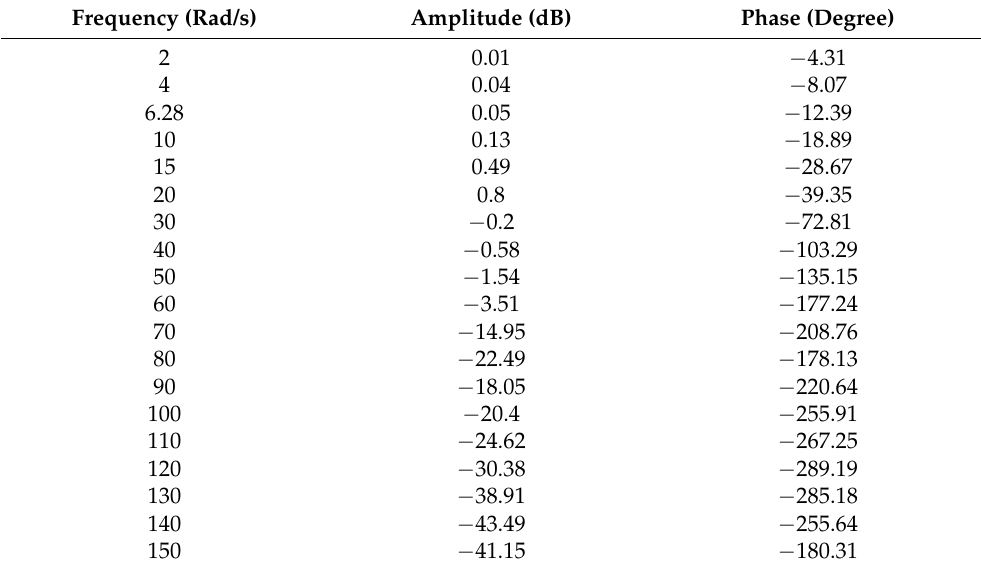
Table 6. The compensated load dynamic response at the specified frequencies with the combined control